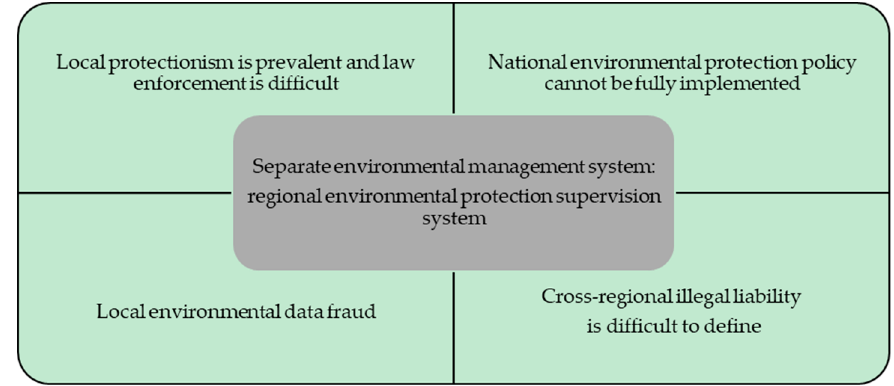
Figure 1. Problems in the regional environmental protection supervision system.